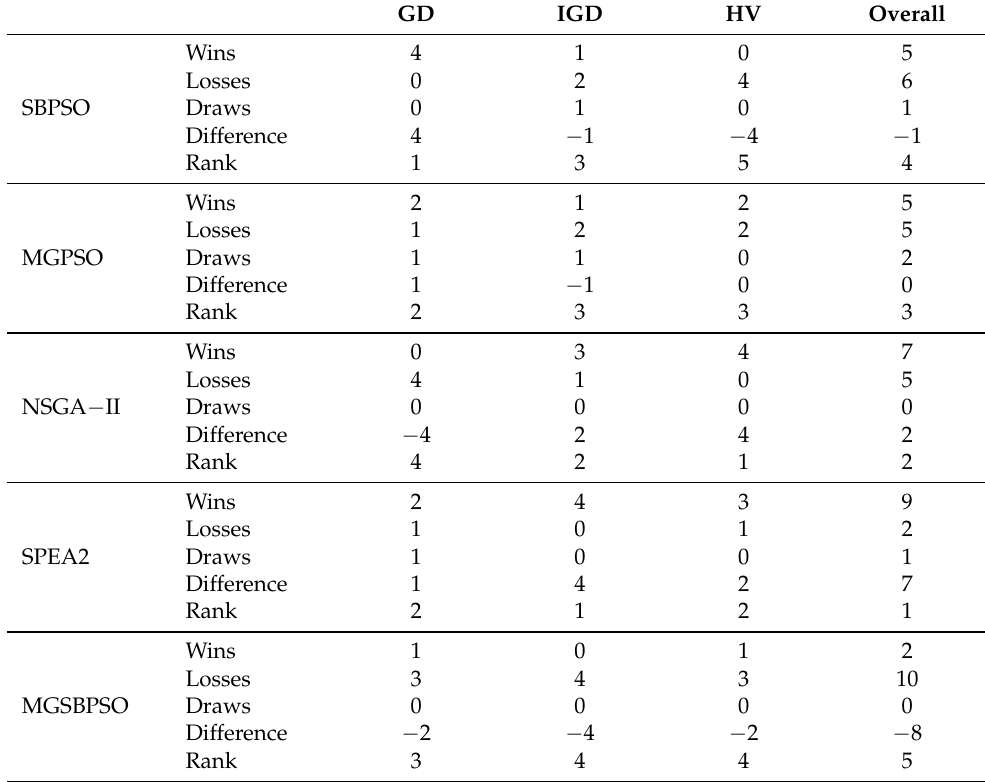
Table 8. DAX 100 rankings for each performance